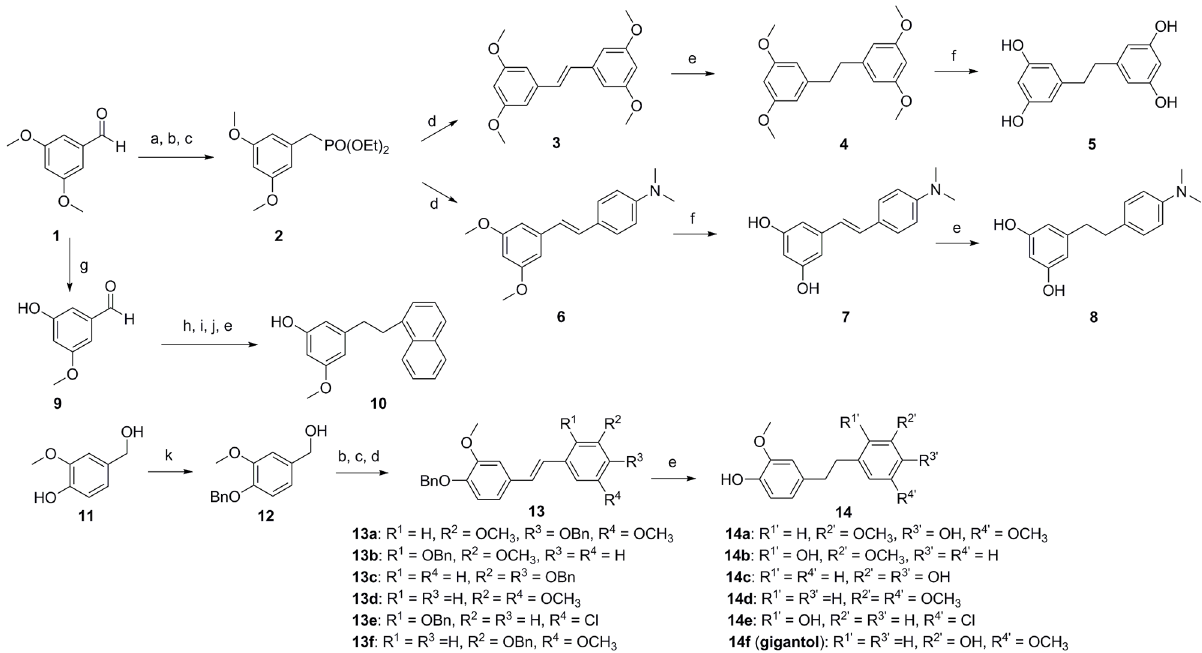
Fig 1. Synthesis of 4, 5, 8, 10, 14, and gigantol. Reagents and conditions: a. NaBH 4 , MeOH; b. PBr 3 , pyridine, 0°C; c. P(OEt) 3 , 120°C; d. different aldehydes, CH 3 ONa, 0°C to room temperature (RT), 12 h; e. Pd/C, H 2 , RT, 12 h; f. BBr 3 , CH 2 Cl 2 , -20°C, 2 h; RT, 4 h; g. NaH, ethanethiol, DMF, N 2 , reflux; h. MOMCl, i -Pr 2 NEt, CH 2 Cl 2 , 0°C, 1 h; RT, 12 h; i. diethyl naphthalen-1-ylmethylphosphonate, CH 3 ONa, 0°C, 1 h; rt, 12 h; j. 2 M HCl, methanol, 50°C, 1 h; k. BnBr, 18-crown-6, K 2 CO 3 , reflux, 9 h.